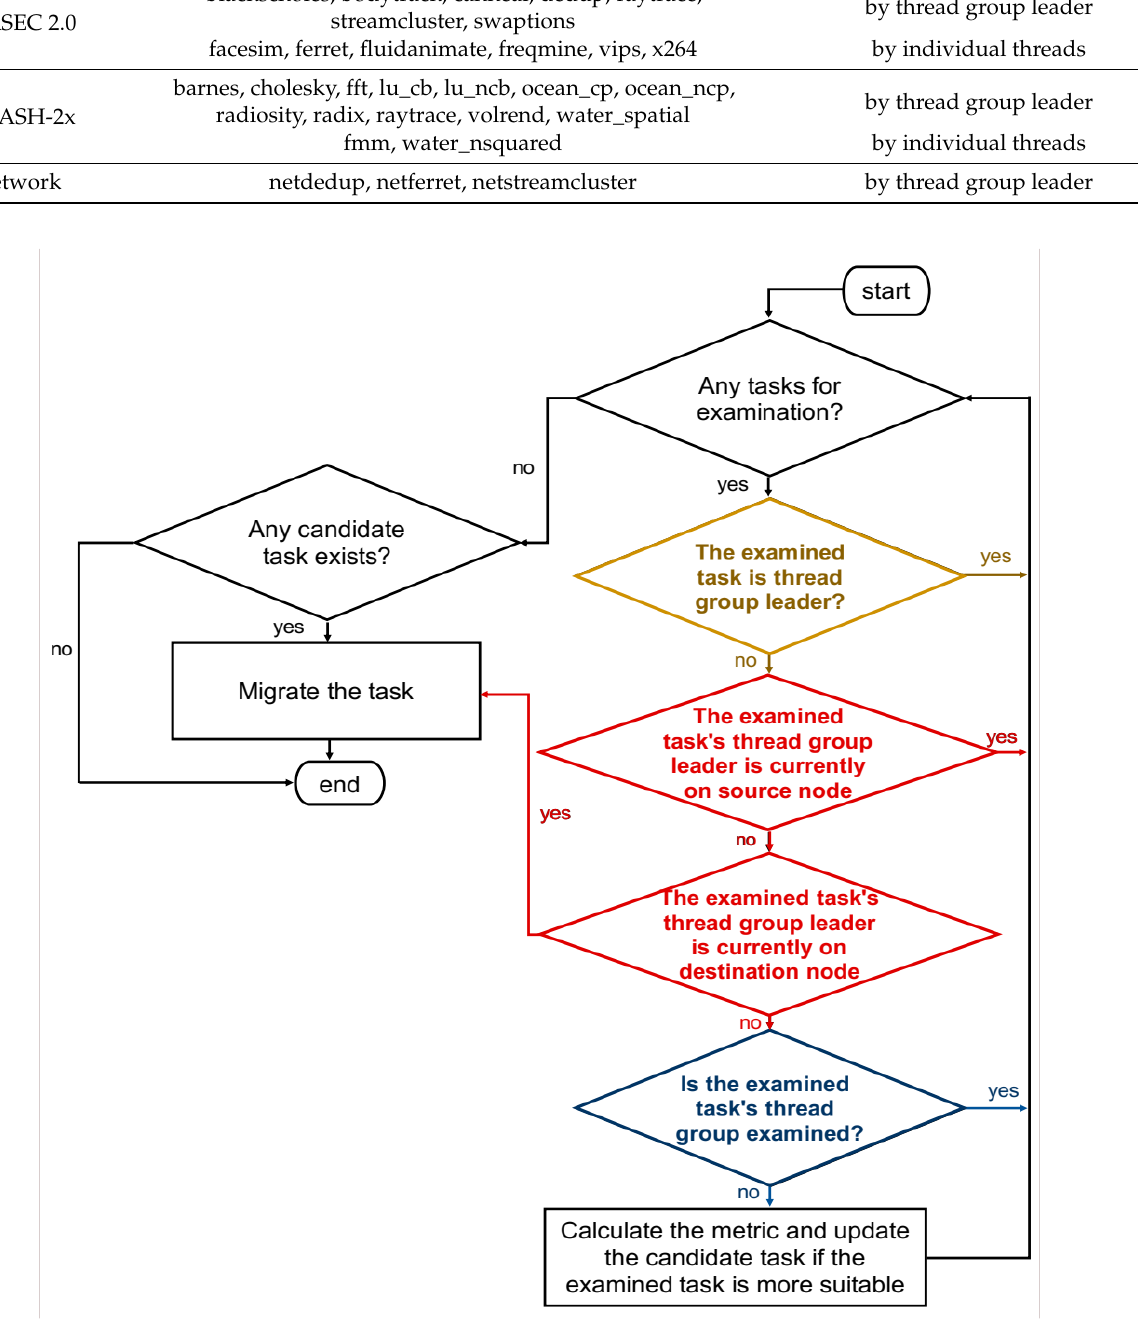
Figure 5. The modified flow for the efficient selection of tasks for inter-node